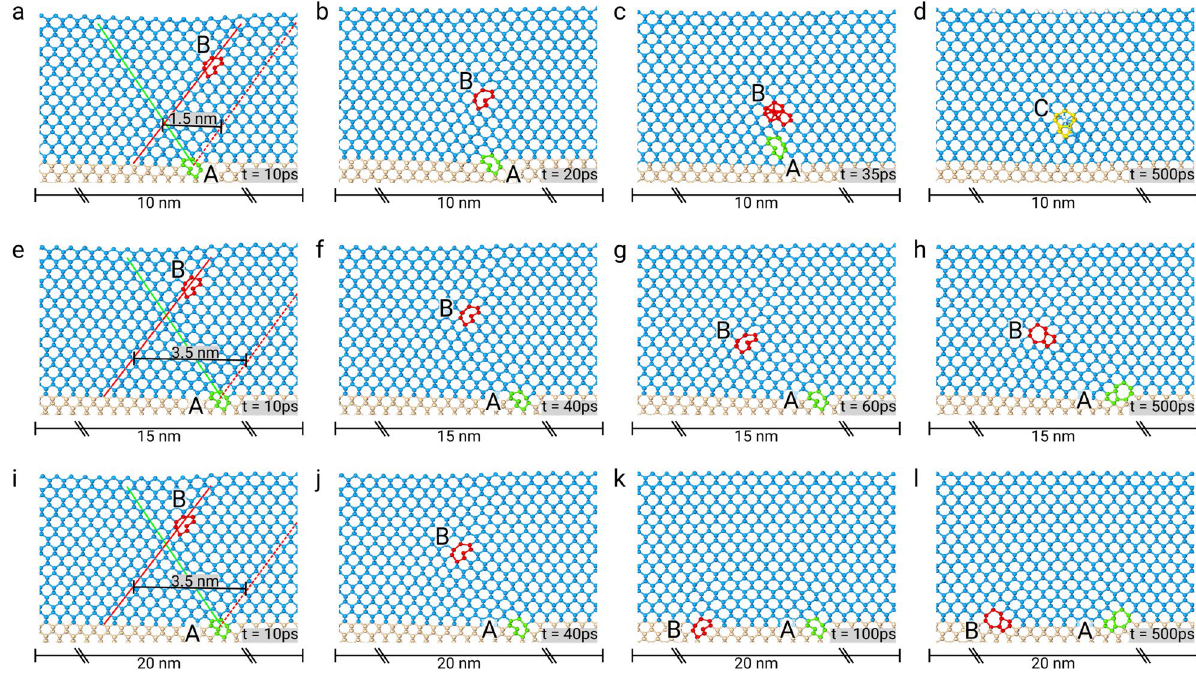
Figure 1. Evolution of complementary dislocations pairs. Each row corresponds to a different simulation performed using different cell sizes to simulate different degrees of relaxation. Light blue spheres represent Ge atoms, pink spheres Si atoms, green spheres highlight the core of the dislocation “A,” which starts at the interface (Burgers vector � b = a / 2 [ 011 ] ), red spheres highlight the core of the complementary dislocation “B”, 1.5nm below the free surface (Burgers vector � b = a / 2 [¯ 10 ¯ 1 ] ). The glide planes of the dislocations are shown in the first row by colored solid lines; the mirror-like glide plane is shown as a dashed line. ( a – d ) Complementary 60 ◦ dislocations joining above the interface forming the pure edge 90 ◦ dislocation “C”; the glide plane of the second dislocation is 1.5nm away from the mirror-like glide plane, and the dimension of the simulated cell is 10nm in the direction perpendicular to dislocation lines. ( e – h ) Complementary 60 ◦ dislocation blocked above the interface; the glide plane of the second dislocation is 3.5nm away from the mirror-like glide plane, and the dimension of the simulated cell is 15nm in the direction perpendicular to dislocation lines. ( i – l ) Complementary 60 ◦ dislocations both at the interface; the glide plane of the second dislocation is 3.5nm away from the mirror-like glide plane, and the dimension of the simulated cell is 20nm in the direction perpendicular to dislocation